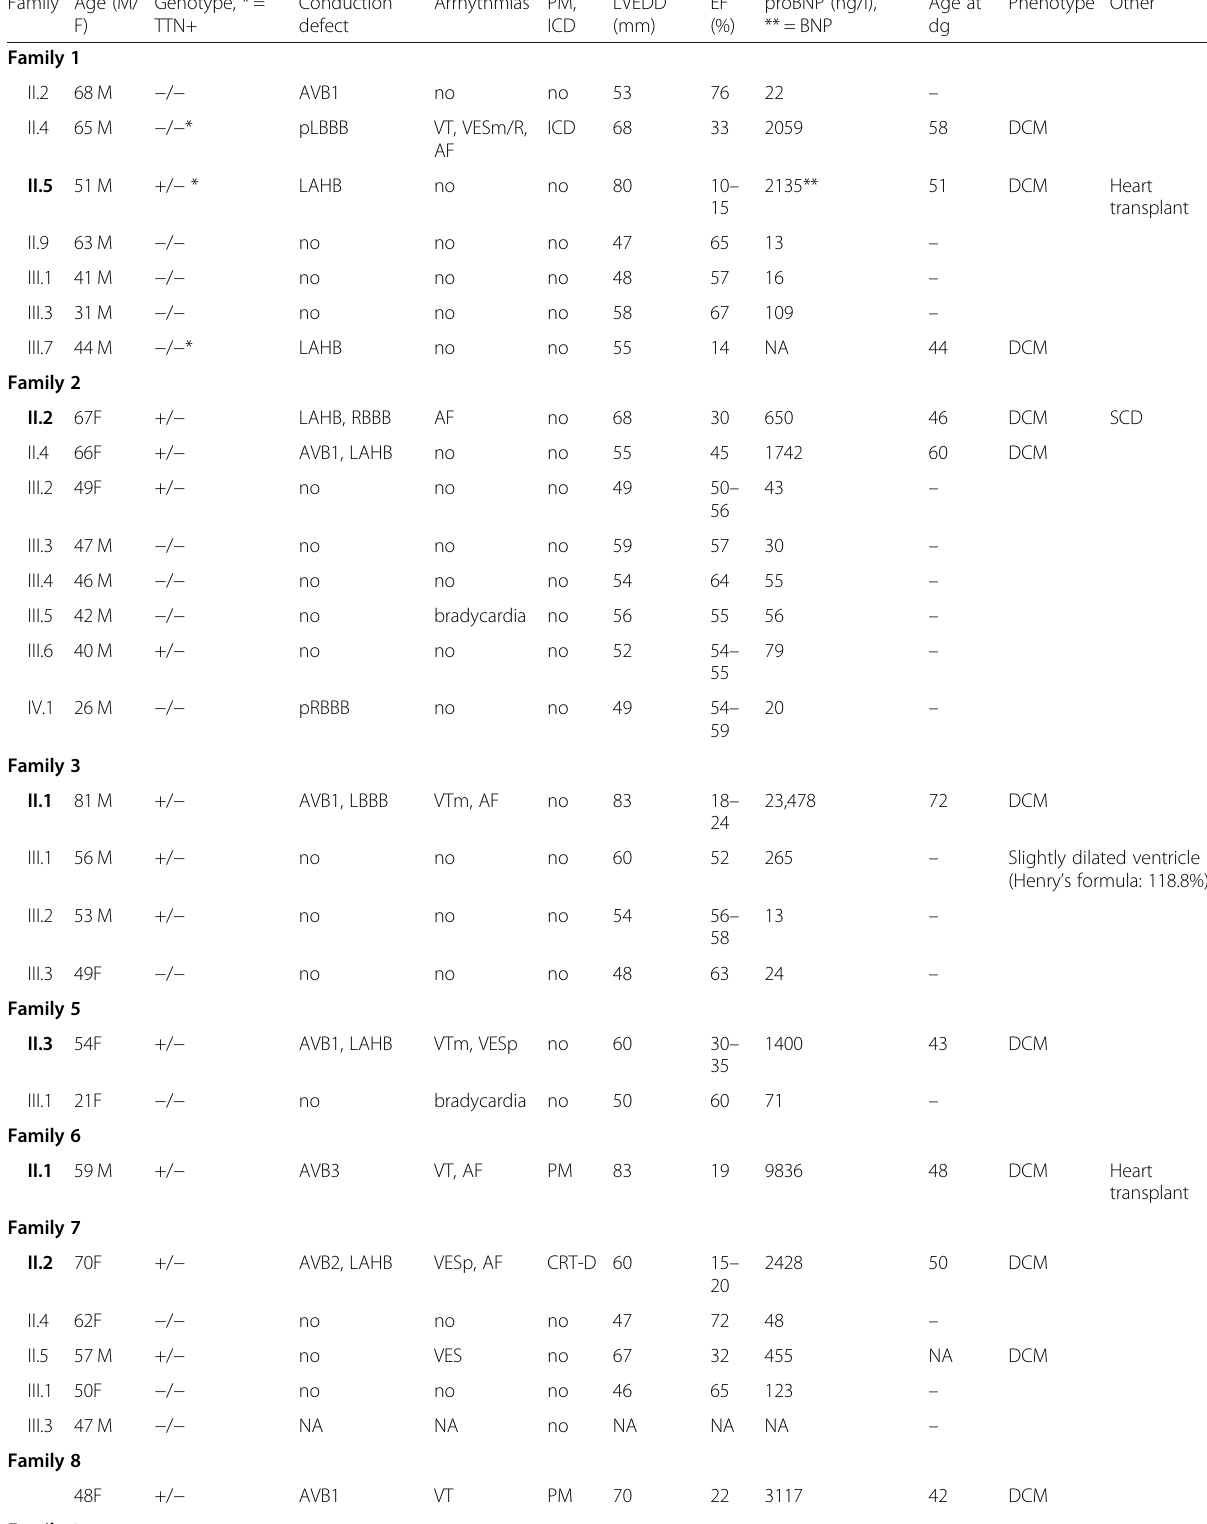
Table 1 The main clinical features of the index patients and their